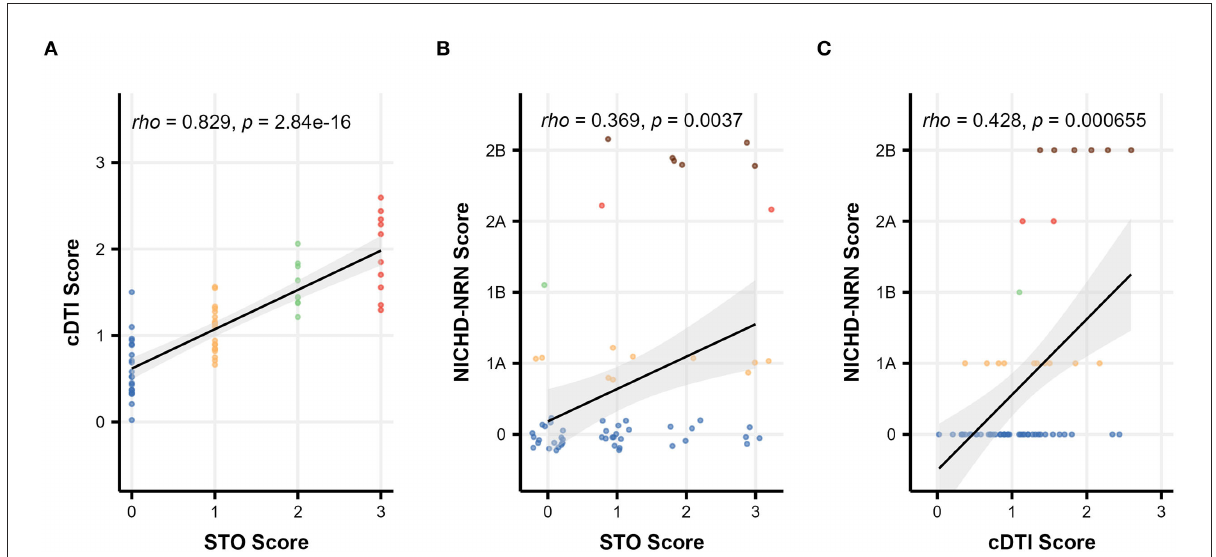
FIGURE3 Scatterplots showing the relationship among severity scales: comparison between (A) the cDTI score and the STO score, (B) the NICHD-NRN score and the STO score, and (C) the NICHD-NRN score and the cDTI score. Solid black lines with gray areas represent the regression lines with 95% confidence intervals, and Spearman’s correlation coefficients/ p -values are shown in the upper left corner of each graph. For (B) , the data are jittered to show the sample size.